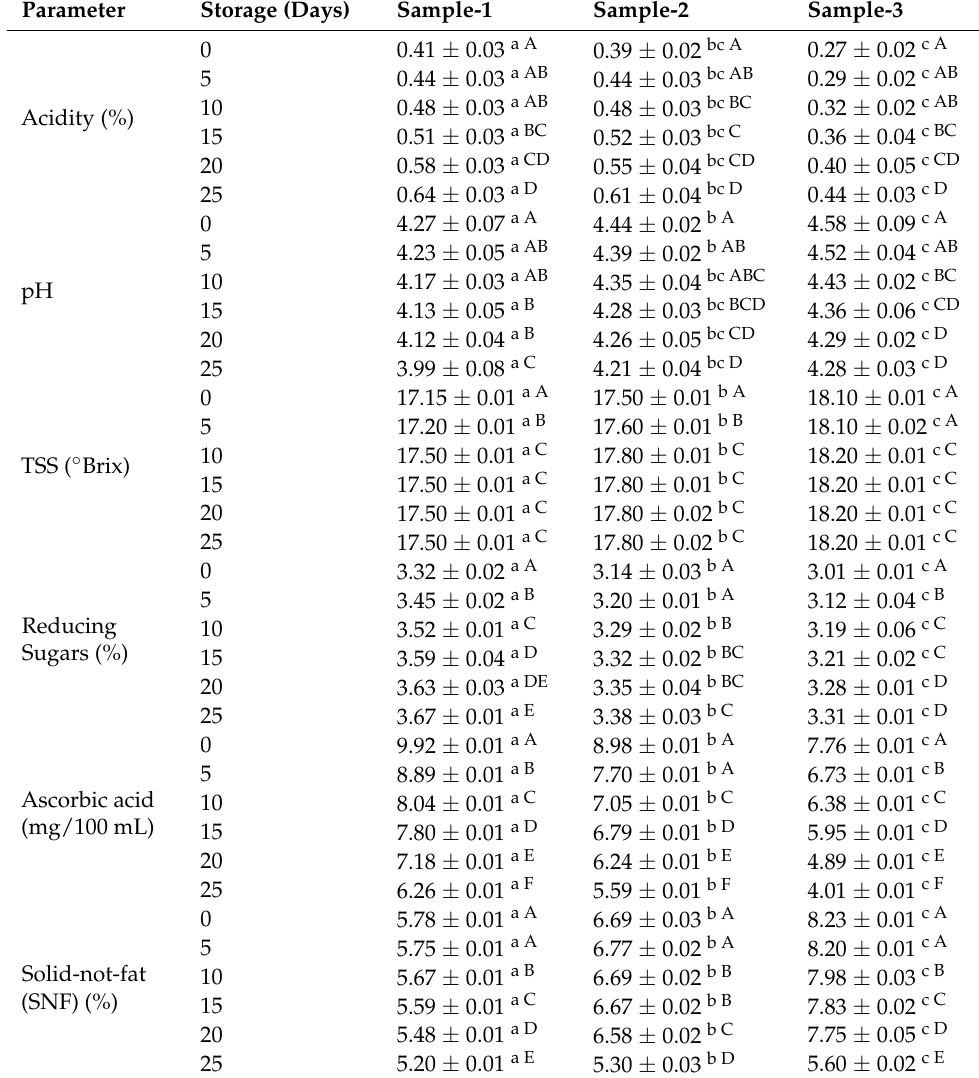
Table 2. Physicochemical analysis of whey-mango based mixed beverage 1